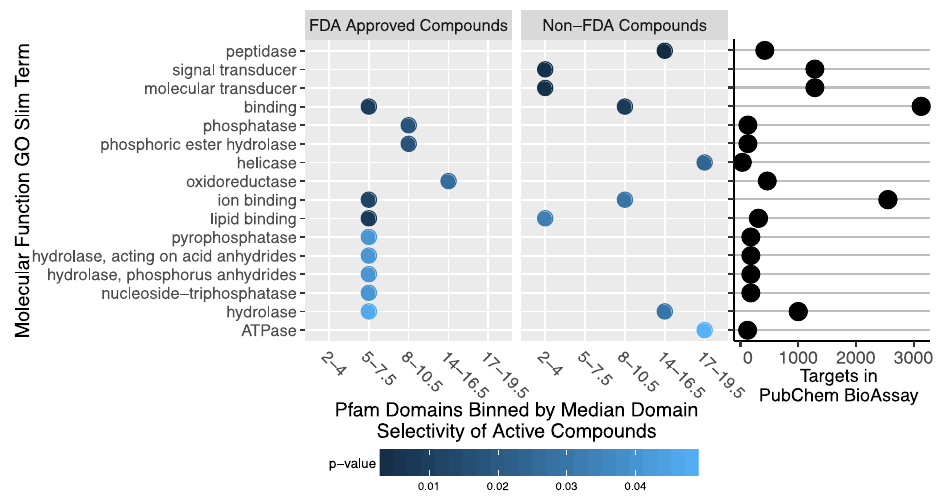
Fig 5. Molecular Function Gene Ontology (MF GO) slim term enrichment vs domain selectivity. Pfam domainsare binnedby the median domainselectivity of active compounds againsttargets with these domains,as in Table 3. The domainsin each bin were computedseparately basedon FDA approved and non-FDA compounds,shown here side by side. For each bin of domainselectivity, the enrichment of MF GO slim terms against the backgroundof all bins is shown. Enrichedterms are sorted increasingly by the lowest p- value obtained,with all terms shownhere havinga p-value < 0.05. The right column dot plot shows the numberof protein targets in PubChemBioAssay annotated with each MF GO slim